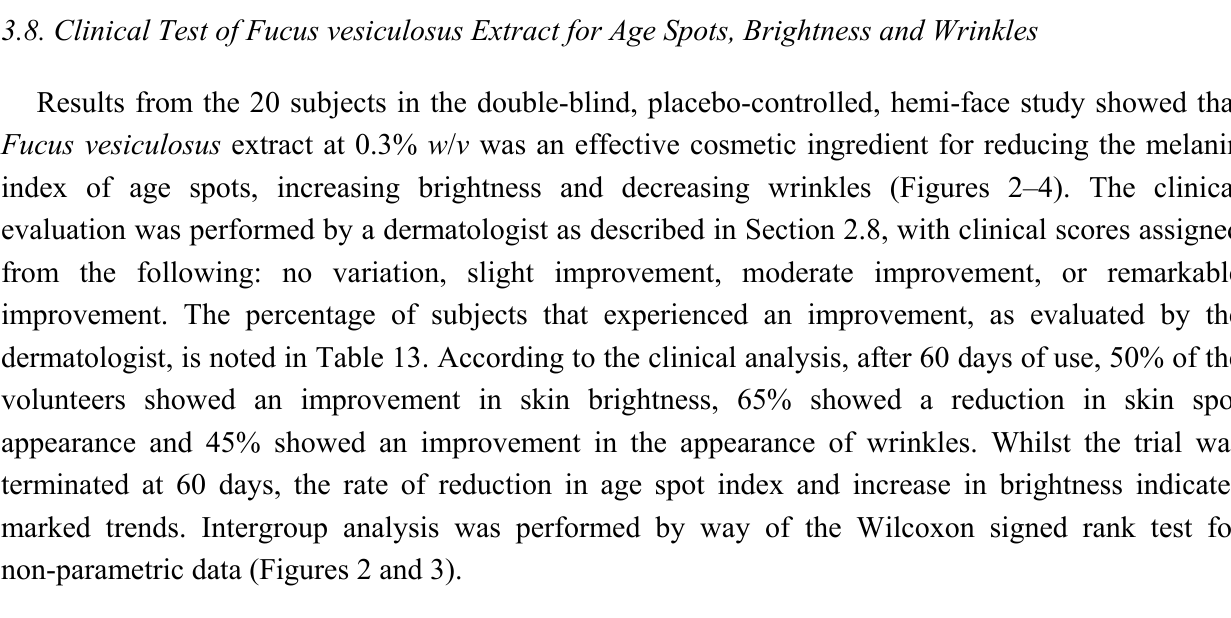
Table 13. Dermatologist clinical analysis of Fucus vesiculosus extract (percentage of subjects showing an